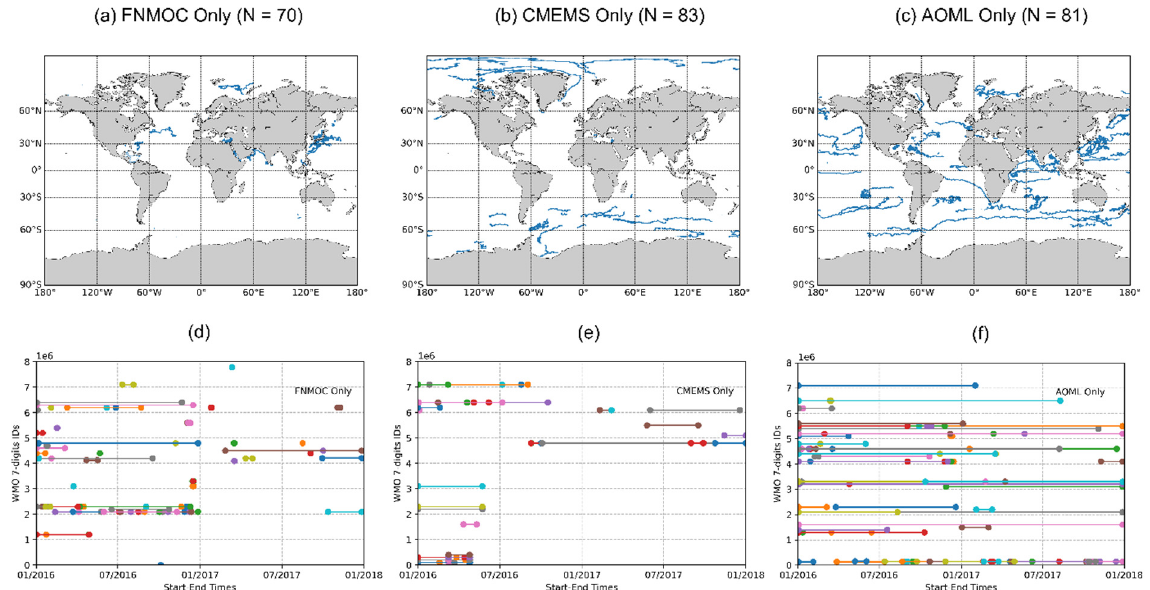
Figure 3. Trajectories of buoys found in (a) only FNMOC, (b) only CMEMS, and (c) only AOML, and life spans of buoys found in (d) only FNMOC, (e) only CMEMS, and (f) only AOML. In the bottom panels, the start and end times of a buoy are marked by two solid circles sharing the same color as the connecting line. The y-axis is the 7-digit WMO ID value.